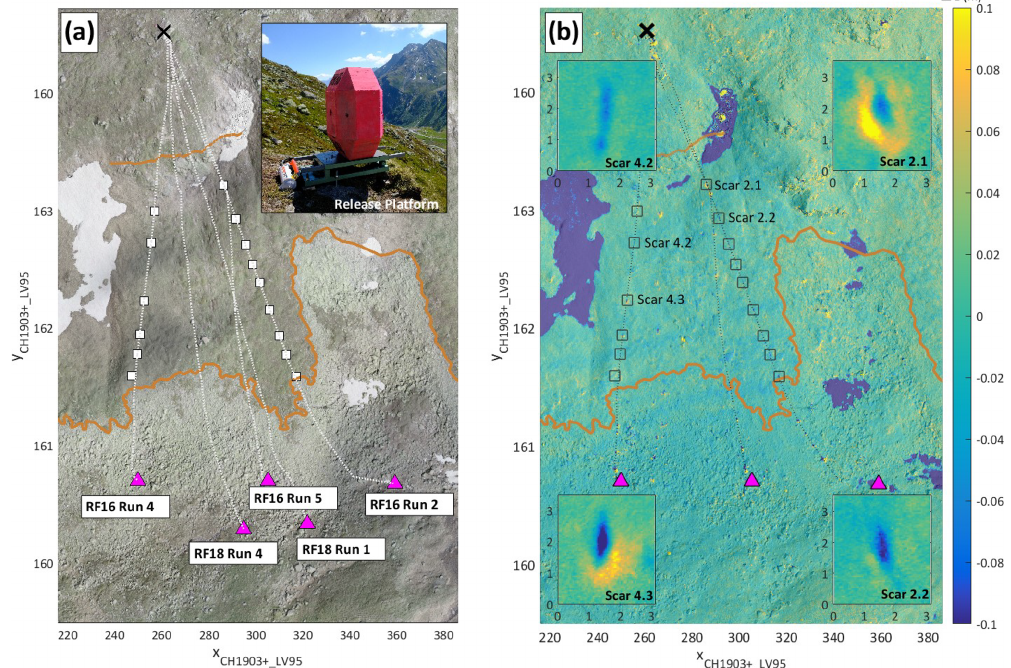
Figure 2. (a) UAS-derived orthophoto of the experimental test site with marked release point and projected travel path of the investigated trajectories alongside with the mapped scars and the final deposition positions of the rocks. The level of the cliff and transition to the scree field are outlined. The inset shows the release platform with the 780kg rock in starting position. (b) Elevation difference map derived from a pre- and post-experimental UAS-generated digital elevation model for RF16. The mapped scars for the presented RF16 runs are indicated with black squares. The course of the trajectories is also visible in the scree field where elevation differences occur due to shifted rocks. Note that the elevation loss of roughly 10cm in the snow fields also serves as qualitative validation of the measured differences. Insets: Characteristic scarring pattern without (Scar 2.2 and 4.2) and with material accumulation (Scar 2.1 and 4.3) in resultant travel